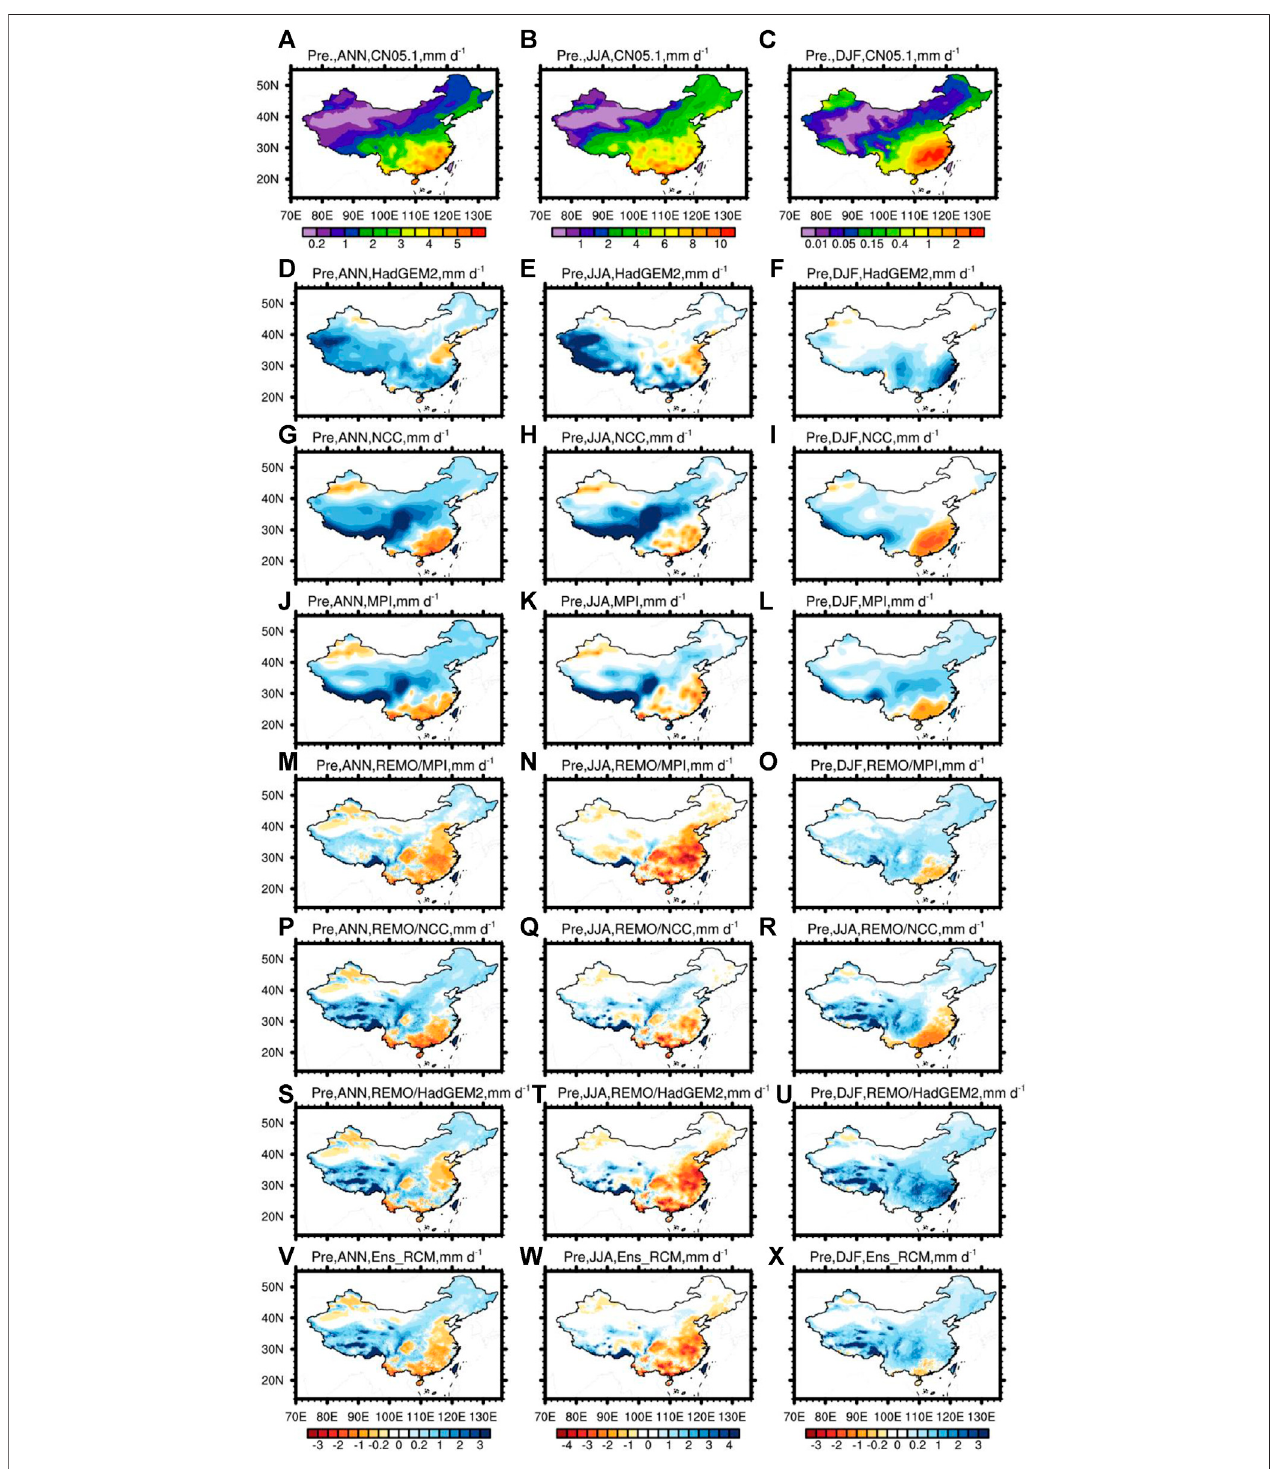
FIGURE 1 | The spatial distributions of the observed annual average (A) , summer (B) and winter (C) precipitation, the biases of the global climate model (GCM) simulations (D – L) , the biases of the regional climate model (RCM) simulations (M – U) and the biases of the RCM ensemble (V – X) .